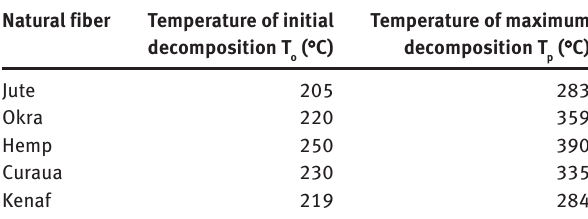
Table 3: Decomposition temperatures for selected natural